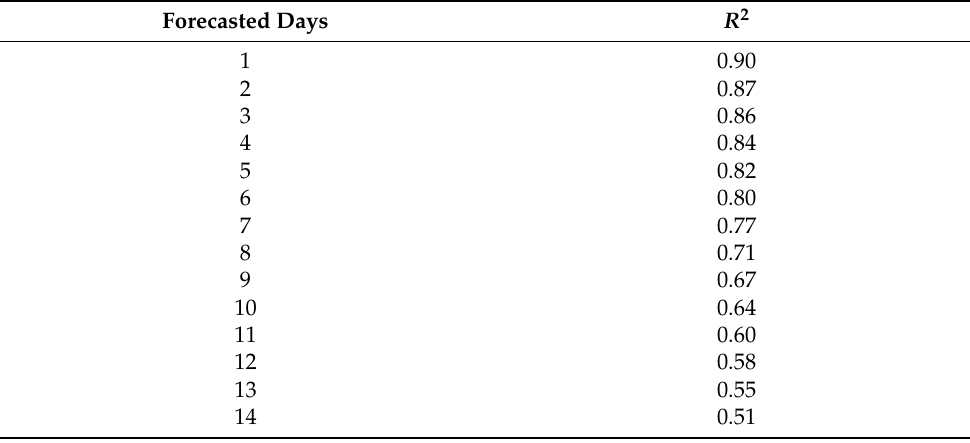
Table 1. Pooled R 2 score for each forecasted